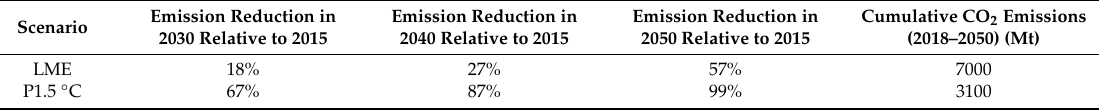
Table 1. Impacts of different scenarios for Australia’s energy-related CO 2 emissions from the modeled sectors.